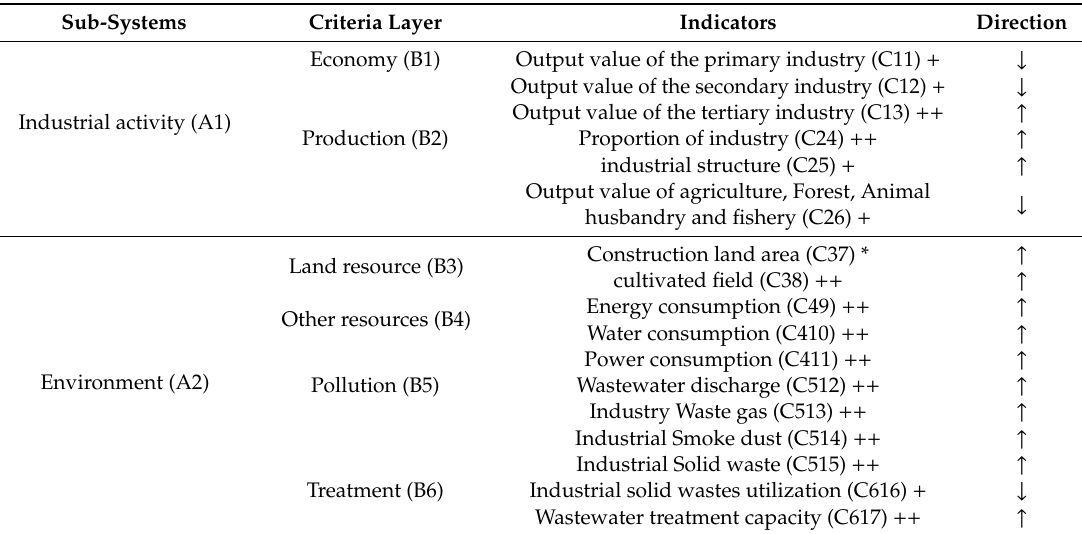
Table 2. Indicators for industry–environmental system resilience